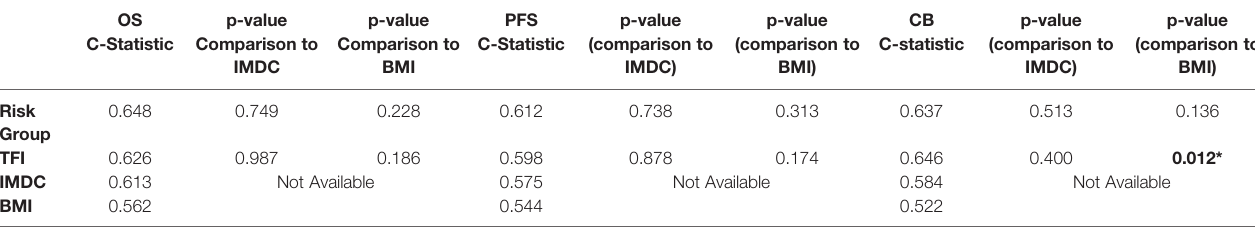
TABLE 3 | Comparison of C-statistics between body composition risk groups, TFI, IMDC, and